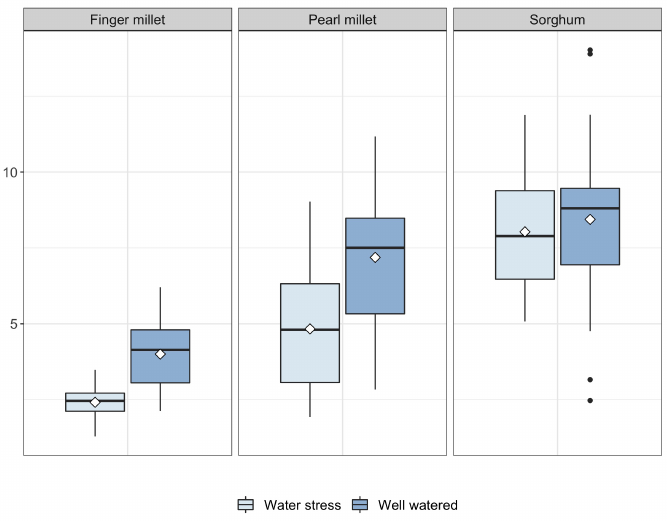
Figure 3. Boxplot of silica accumulation % values of finger millet, pearl millet and sorghum by water treatments. Horizontal bar = median, white diamond = mean, black dots =